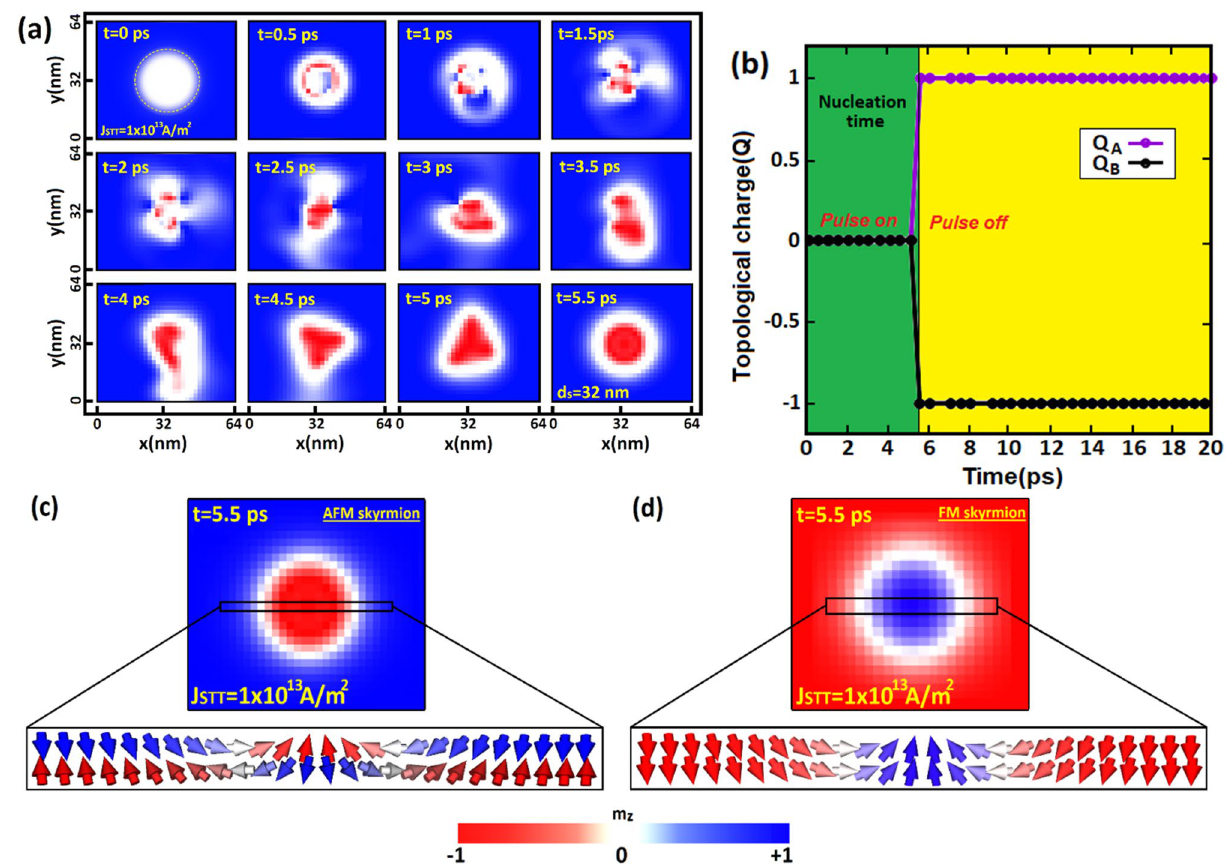
Figure 3. ( a ) Snapshots of the nucleation steps of isolated AFM skyrmion using a vertically injected spin- polarized current (STT) perpendicular-to-plane (CPP) of the 2D AFM layer in a circular region (yellow circular). ( b ) The time evolution of topological charge Q A and Q B during the nucleation. ( c,d ) Snapshots of isolated AFM and FM skyrmions after the nucleation time.